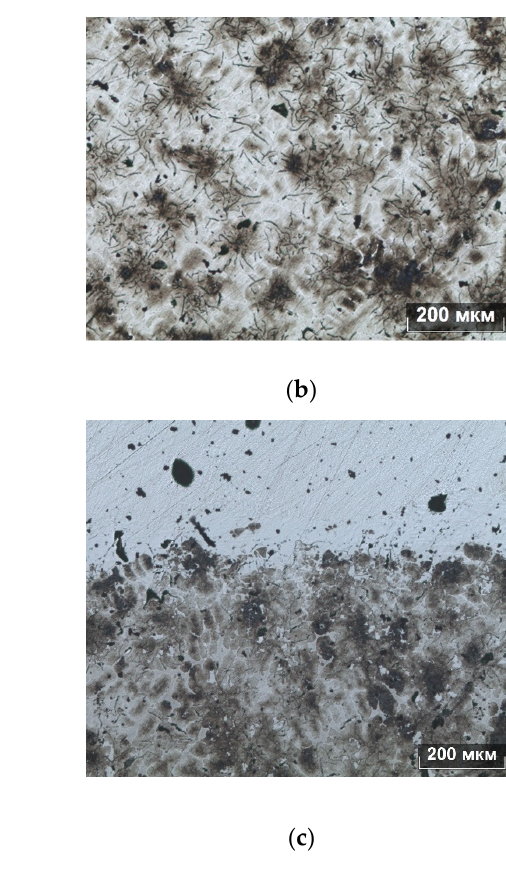
Figure 9. ( a )—hardness measurement in HV from cladding to cast-iron with a step of 200 µm, the structure of the material was investigated using a Leica optical microscope: ( b )—structure of cast-iron-before cladding; ( c )—structure of cast-iron with cladding. Separate hardness measurements were made at four to five points for each area of interest: cast-iron without surfacing is 240 ± 60 HV, with weld overlay 467 ± 76 HV, hardness of deposited Inconel 625 corresponds to 462 ± 26 HV, hardness in the transition zone is 601 ± 134 HV. Examination of the state of the interface on an optical microscope (Figure 9c) showed a strong metallic bond of the cladding with the star material: there were no cracks or pores at the